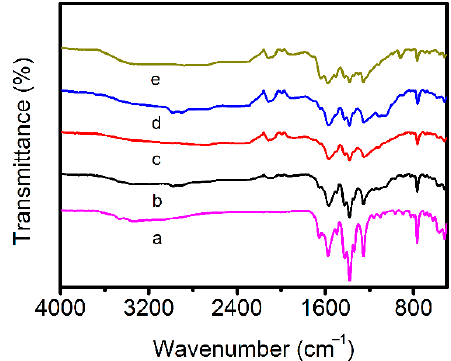
Figure 2. The Attenuated total internal reflection Fourier (ATR-FTIR) spectra of (a) MIL-101(Fe), (b) GO10-MIL-101(Fe), (c) GO15-MIL-101(Fe), (d) GO20-MIL-101(Fe) and (e) GO-15-MIL-101(Fe) loaded with